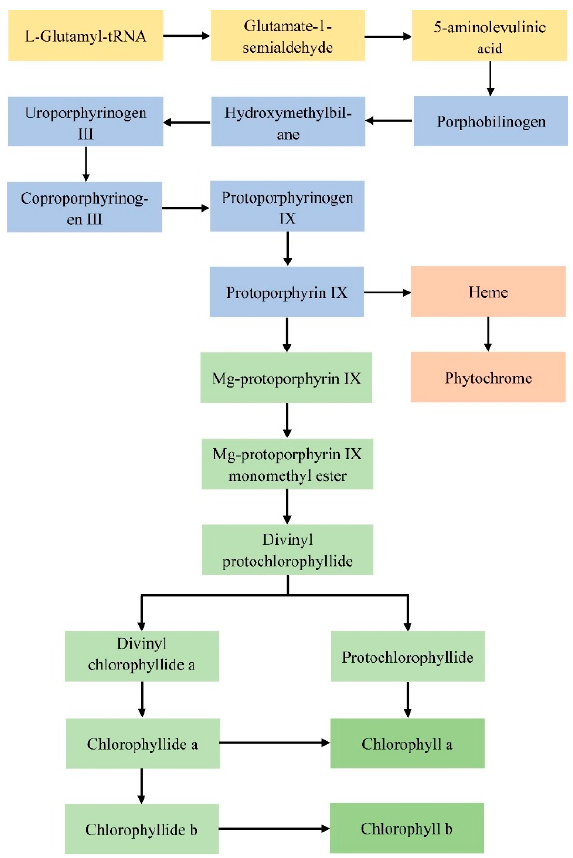
Figure 1. Biosynthetic pathway of angiosperm chlorophyll.